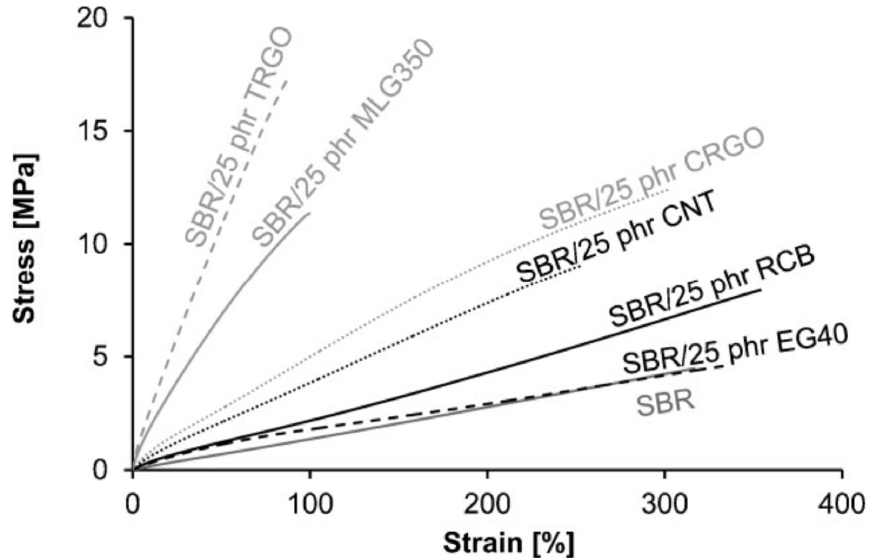
Figure 8. Stress-strain curves of SBR with 25 phr of different carbon fillers. Reproduced with permission from [79], Copyright Wiley, 2014.